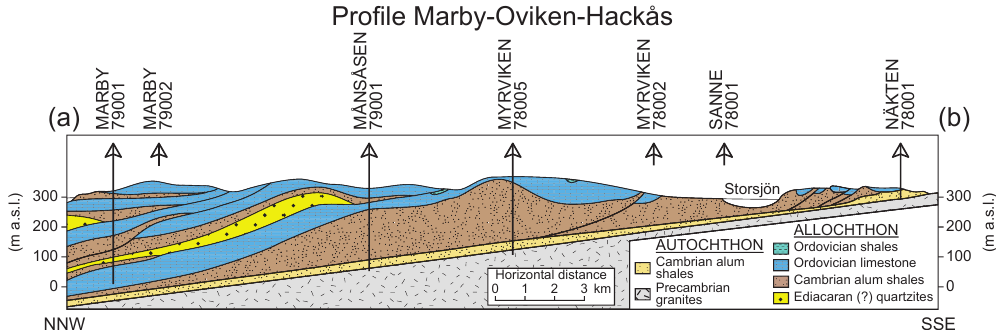
Figure 3. Geological cross section through the Myrviken area boreholes based on the SGU report on alum shales (Gee et al., 1982), shown at a vertical exaggeration of 10 :